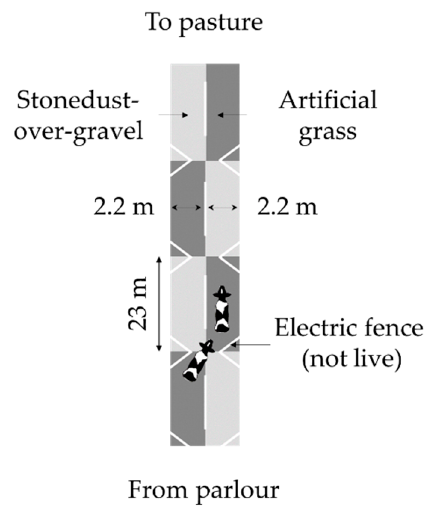
Figure 2. Setup used for the preference trial in which dairy cows’ could choose between surface types. Figure not to scale.